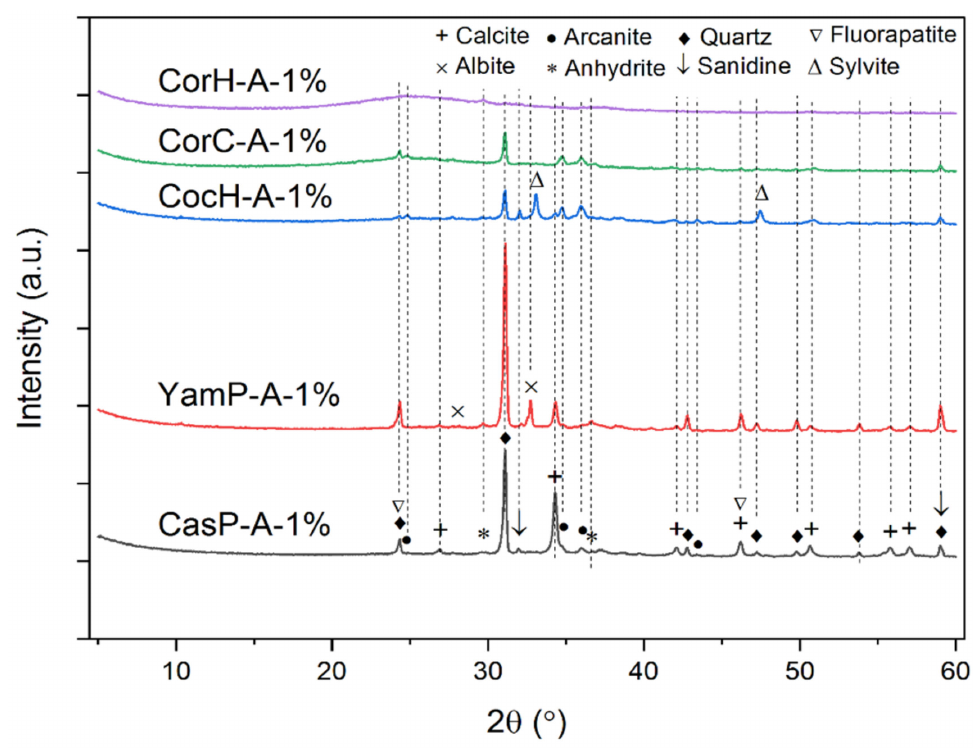
Figure 7. X-ray diffraction pattern of the ash samples resulting from the combustion of 1 w / v % acid-treated biomass fuels at 600 ◦ C.